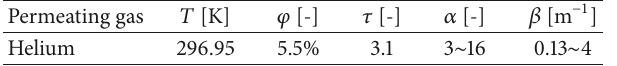
Table 2: Parameters for the sensitivity